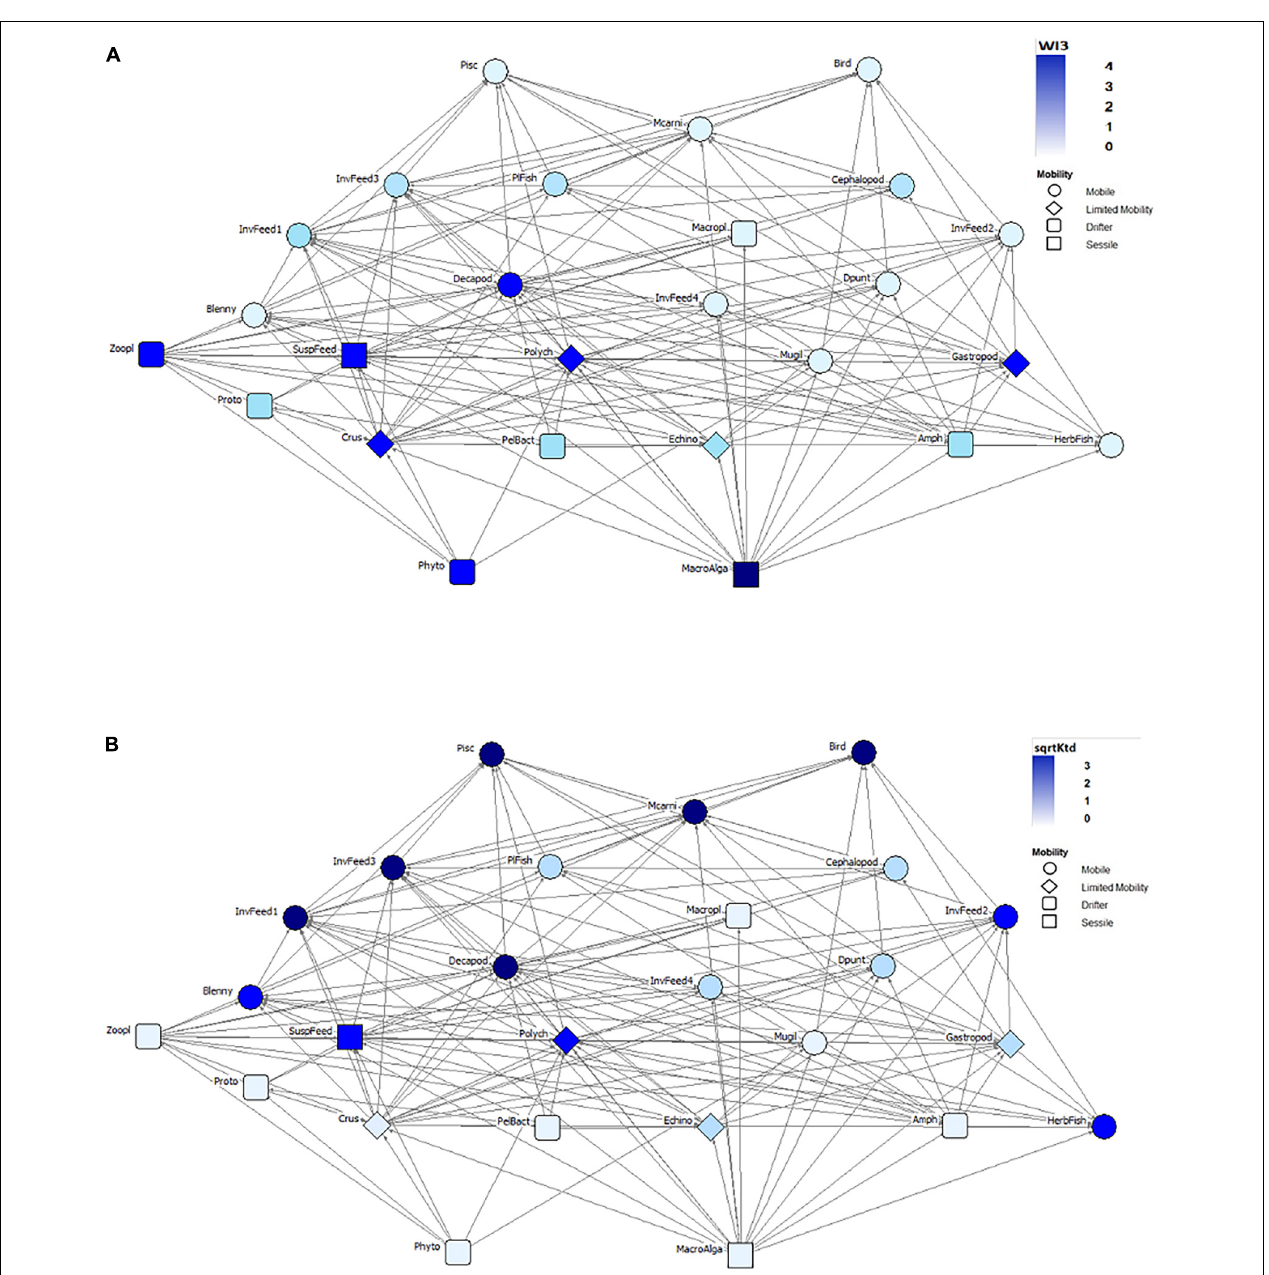
FIGURE 3 | The food web of Bay of Calvi (Pinnegar and Polunin, 2004) showing the relationship between the topological position of nodes (node color, see values in the inset) for logWI 3 (A) and sqrtK td (B) and their mobility values (node shape, see categories in the inset). The abbreviations for the n = 26 trophic groups are: Phyto, phytoplankton; MacroAlga, macroalgae; Proto, pelagic protozoa; Crus, Crustacea; PelBact, pelagic bacteria; Echino, Echinoderms; Amph, Amphipods; HerbFish, herbivorous fish; Zoopl, zooplankton; SuspFeed, suspension feeders; Polych, polychaetes; Mugil, Mugilidae; Gastropod, gastropods; Blenny, omnivorous blennies; Decapod, decapods; Dpunt, Diplodus puntazzo ; Macropl, macroplankton; PlFish, planktivorous fish; Cephalopod, cephalopods; Mcarni, macrocarnivorous fish; Pisc, piscivorous fish; Bird, seabirds; InvFeed1 through InvFeed4, benthic invertebrate feeders (groups 1–4).